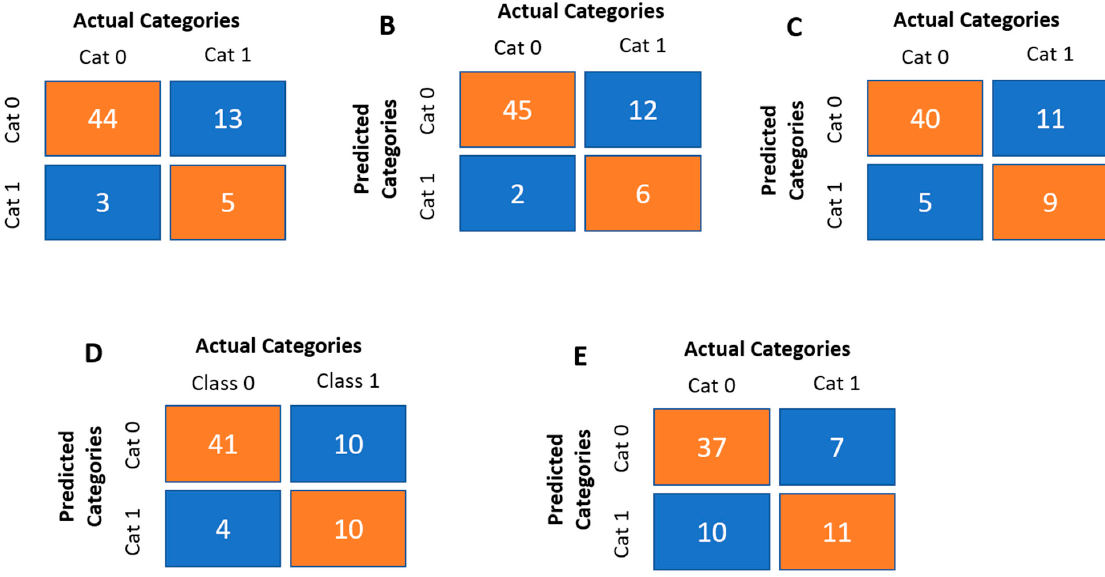
Figure 4. Confusion matrixes of the five models. Confusion matrix reporting the number of ( A )